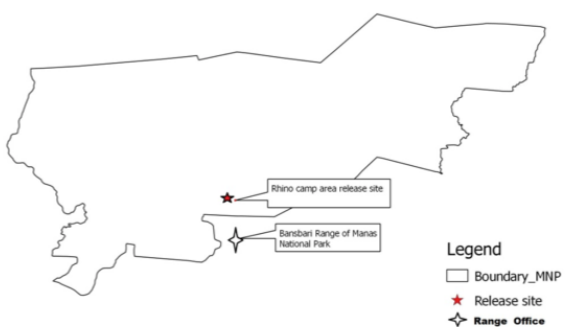
Figure 4. Rhino Camp area rhino release